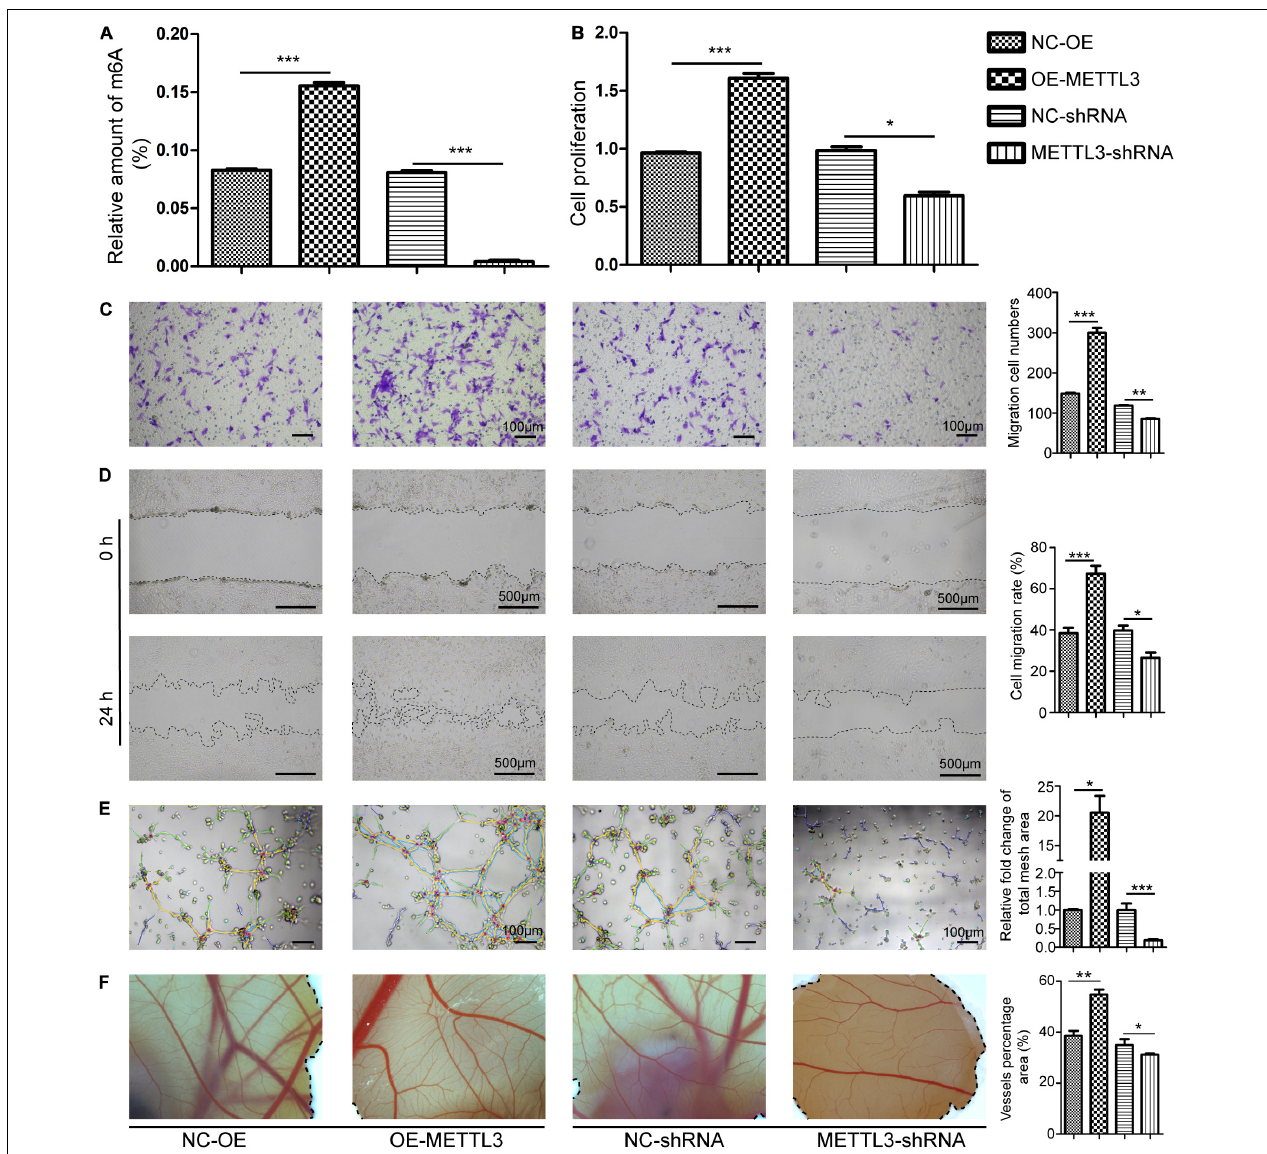
FIGURE 2 | Methyltransferase-like 3 impacts m 6 A methylation and EPC-mediated angiogenesis. (A) Total m 6 A RNA methylation levels were quantified in EPCs following knockdown or overexpression. (B) Endothelial progenitor cell proliferation was measured via CCK-8 assay. METTL3 overexpression enhanced cellular proliferation, while silencing impairs such proliferation. (C–F) In vitro EPC angiogenesis was measured through Transwell (C) , Wound healing (D) , and Tube formation assays (E) . Scale bars: 100 and 500 µ m. (F) METTL3 affects ex vivo angiogenesis. CAM assays revealed that METTL3 overexpression significantly increased vascular density, while METTL3 inhibition had the opposite effect. NC-OE and OE-METTL3 groups or NC-shRNA and METTL3-shRNA groups were compared via Student’s t -tests. * P < 0.05, ** P < 0.01, *** P < 0.001. All cell experiments were conducted in triplicates using three individual cell lines.